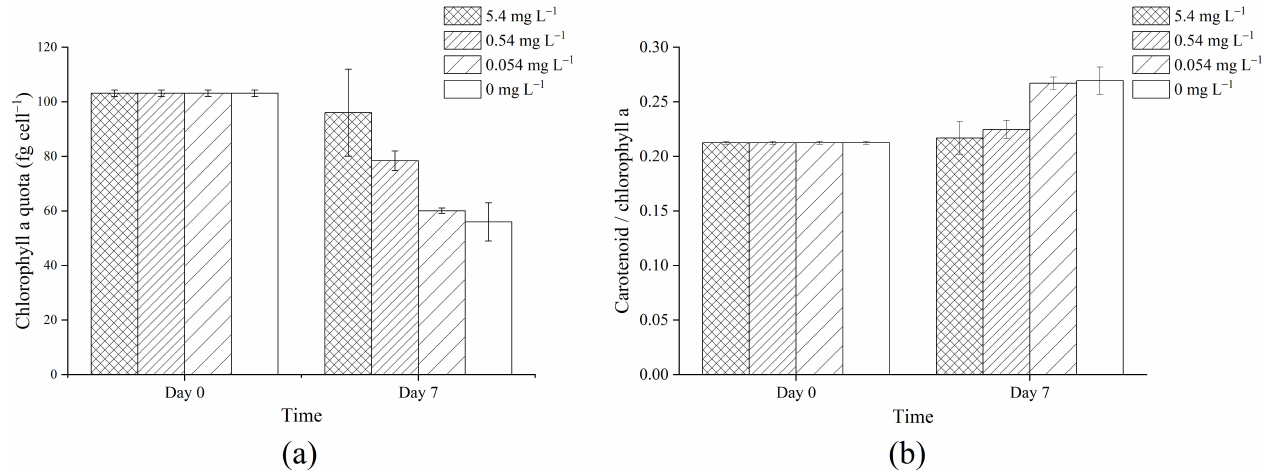
Figure 2. Changes in chlorophyll a content ( a ) and carotenoid/chlorophyll a ratio ( b ) in cultures of Microcystis aeruginosa FACHB-905 after 7 days of growth at different initial phosphorus concentrations. Columns with different filling represent different initial phosphorus concentrations. Error bars indicate standard deviation from three biological replicates.